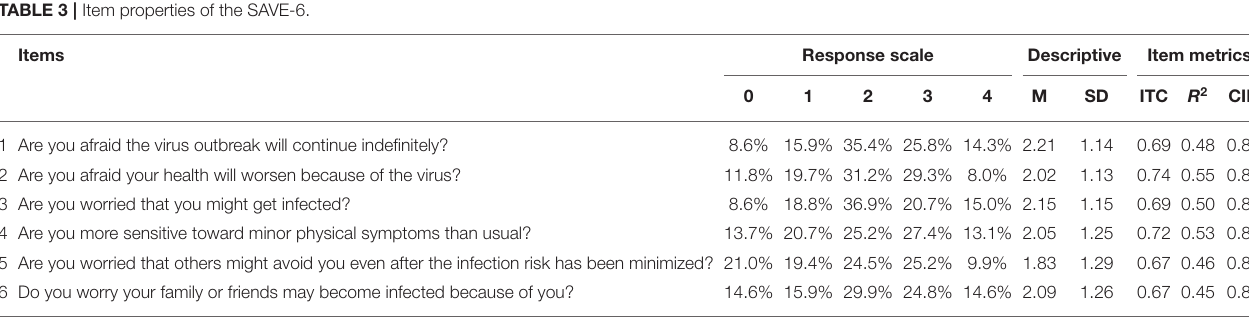
TABLE 3 | Item properties of the